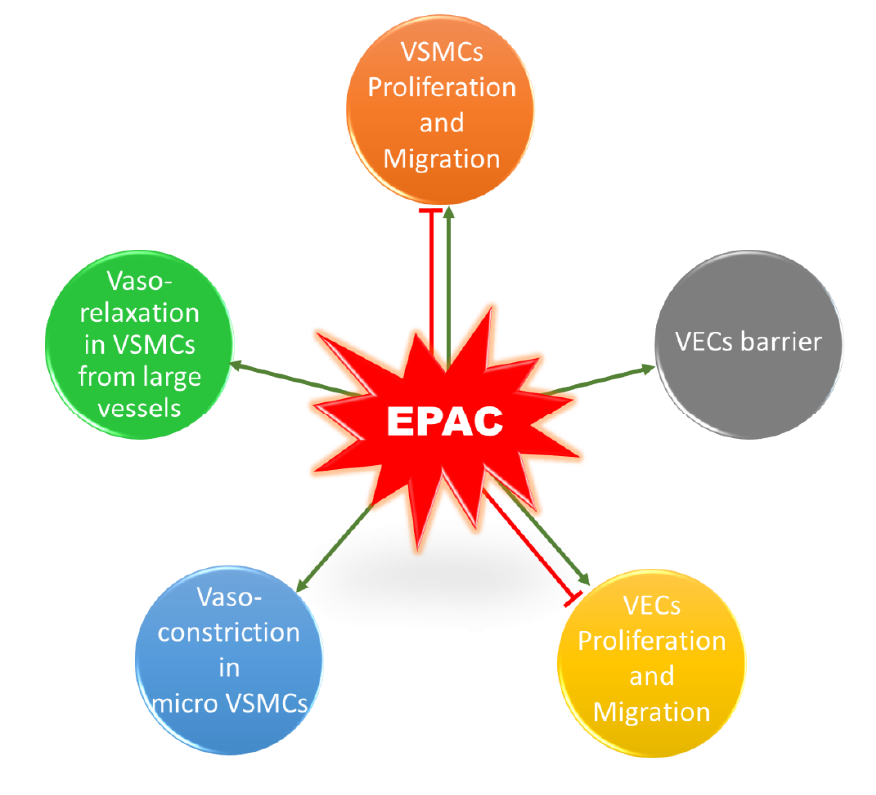
Figure 4. Role of EPAC in the vasculature. EPAC can promote or inhibit proliferation and migration in VSMCs. In addition, EPAC induces vasorelaxation in VSMCs extracted from large vessels, whereas it mediates cold-induced vasoconstriction in microVSMCs. EPAC has a controversial role in VECs; it can promote or inhibit cell proliferation and migration. EPAC also enhances VECs barrier and decreases permeability.